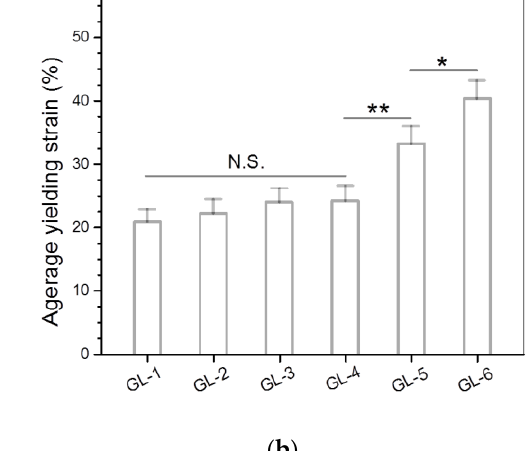
Figure 4. Frequency-dependent variations in G ′ ( a ) and G ″ ( b ) as well as average values of G′ ( c ) and G″ ( d ) at 1 Hz for gels illustrated in Table 2 (*, p < 0.05; **, p < 0.01; ***, p < 0.001; N.S., not sig- nificant).